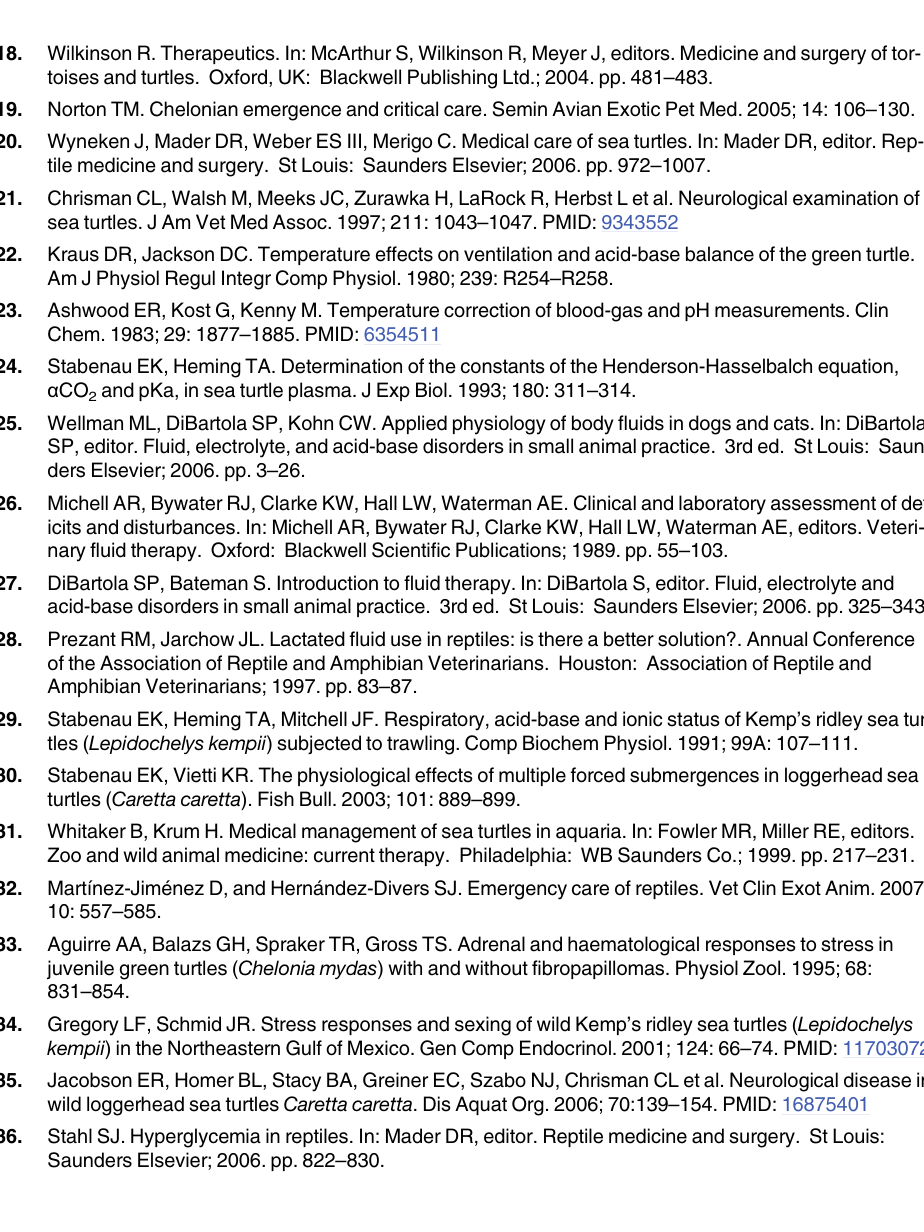
PLOS ONE | DOI:10.1371/journal.pone.0132217 July 13,